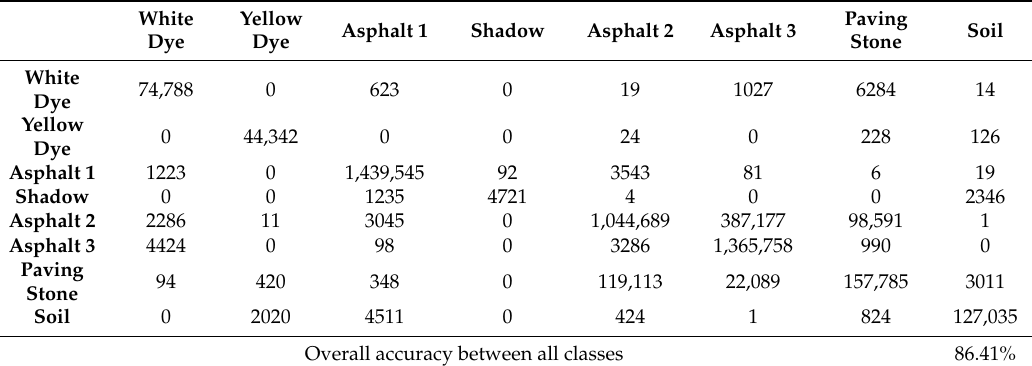
Table 5. Confusion matrix for Image 4.